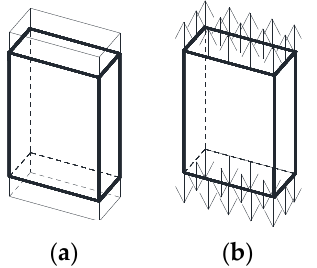
Figure 1. Plate subjected to ( a ) imposed displacement and ( b ) applied tensile load.